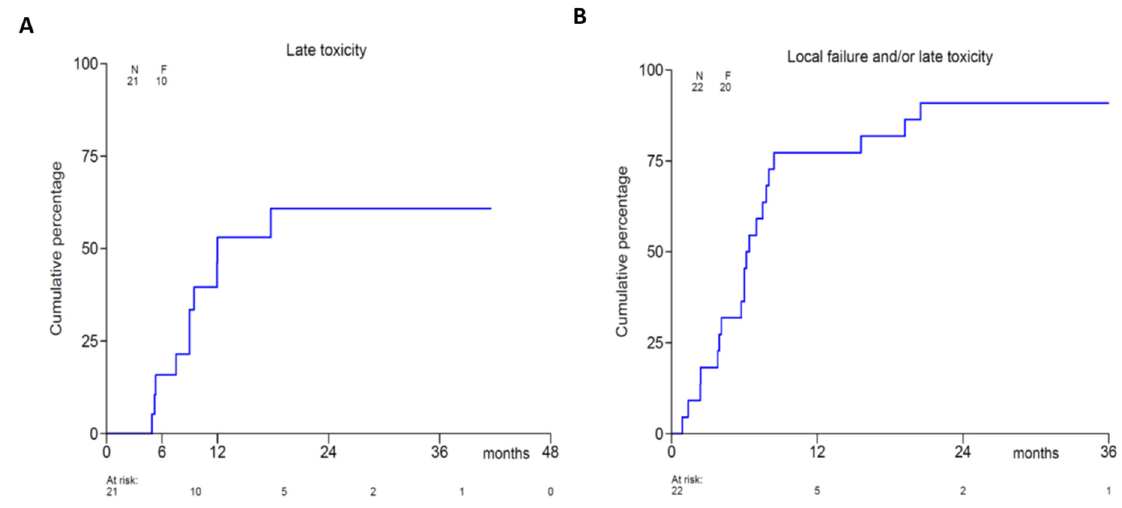
Figure 4. Kaplan-Meier analysis of late (>4 months) grade 3 or higher toxicity ( A ) and grade 3 or higher toxicity and/or local recurrence ( B ). Table 3. Description of toxicity at baseline, end of radiotherapy treatment, 3–4 months and 12 months post-treatment.